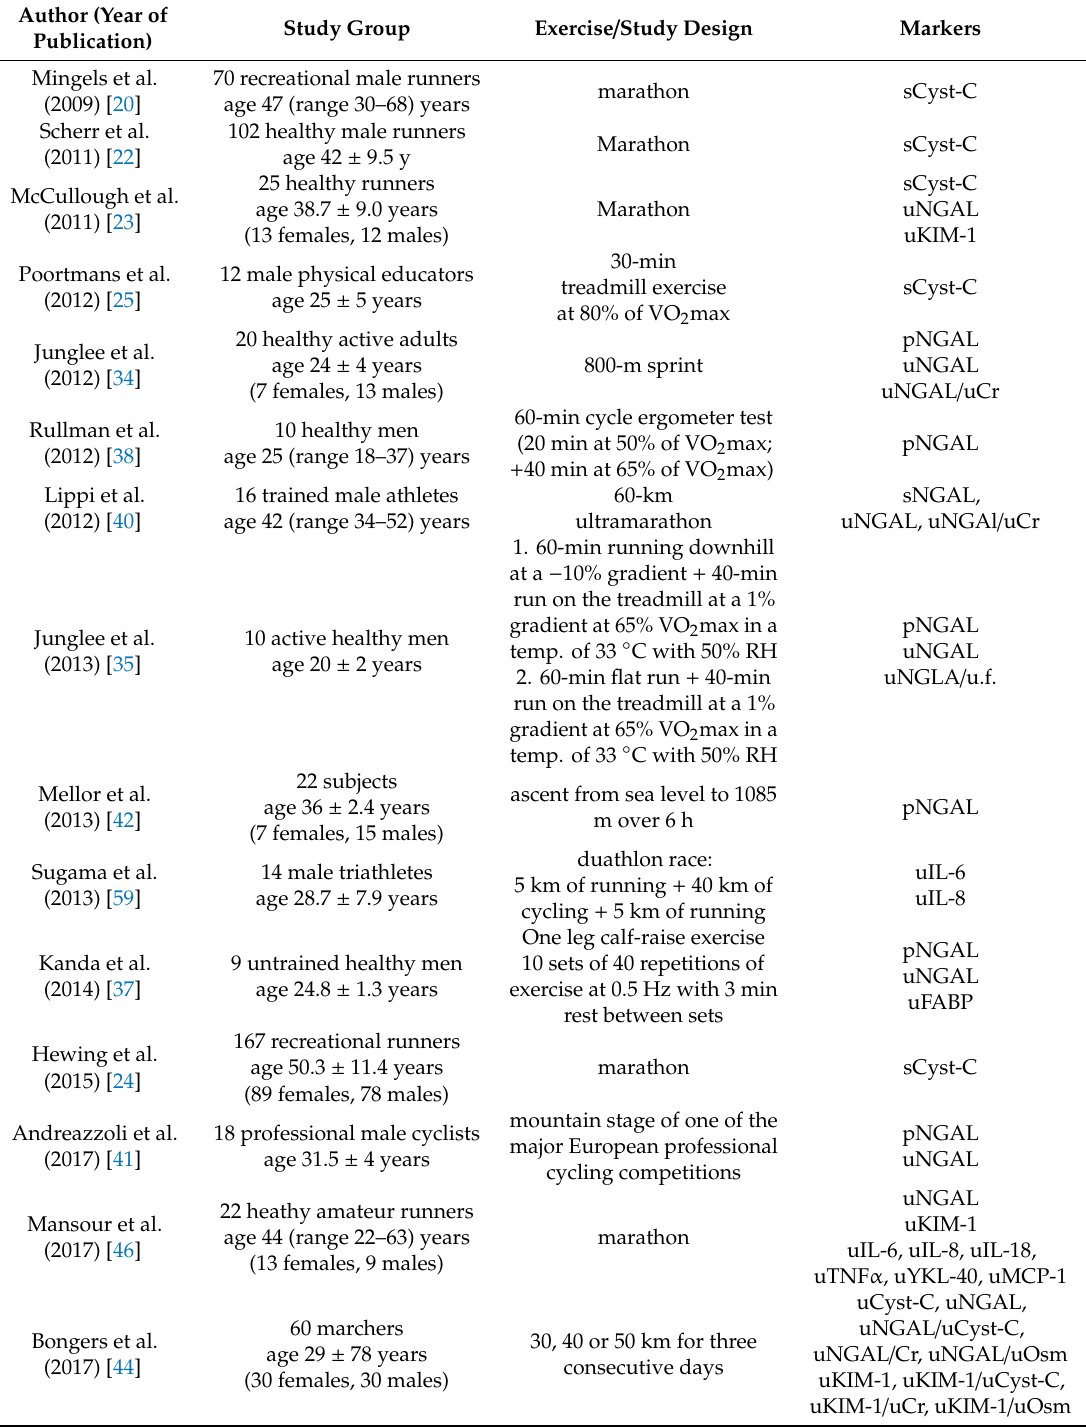
Table 4. Studies on changes in new AKI markers after single exercise in healthy subjects—ordered according to the year of